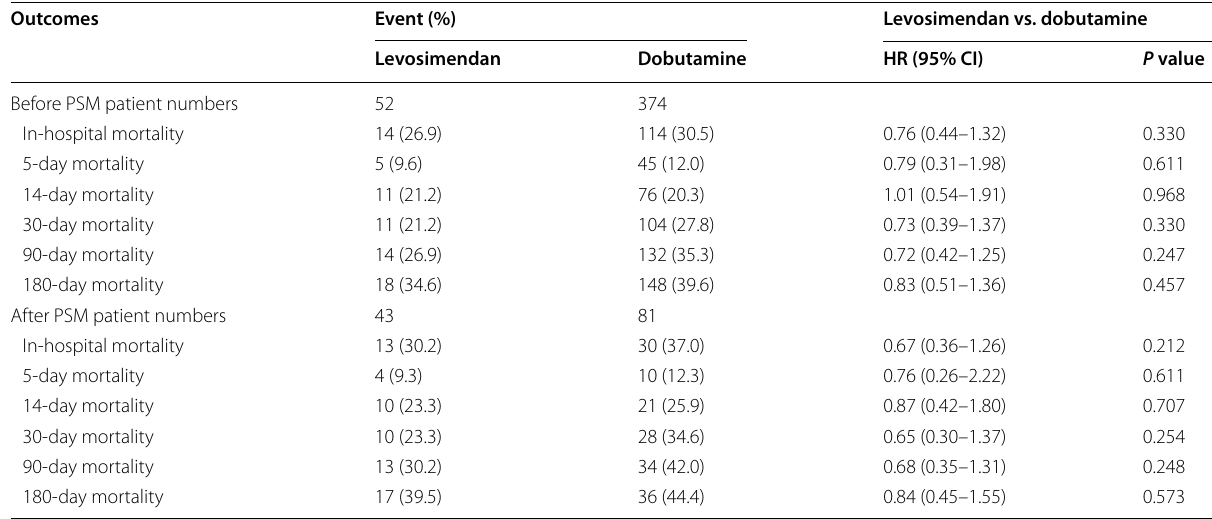
HR hazard ratio, CI confidence interval, PSM propensity score matching